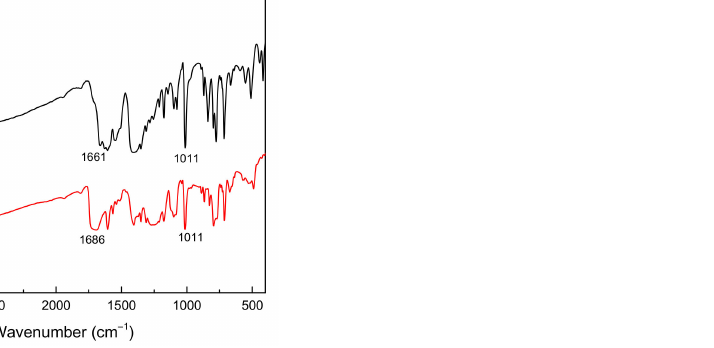
Figure 1. FT-IR spectra of TCPP(Pd) and the prepared Zn–TCPP(Pd) MOF nanosheets.